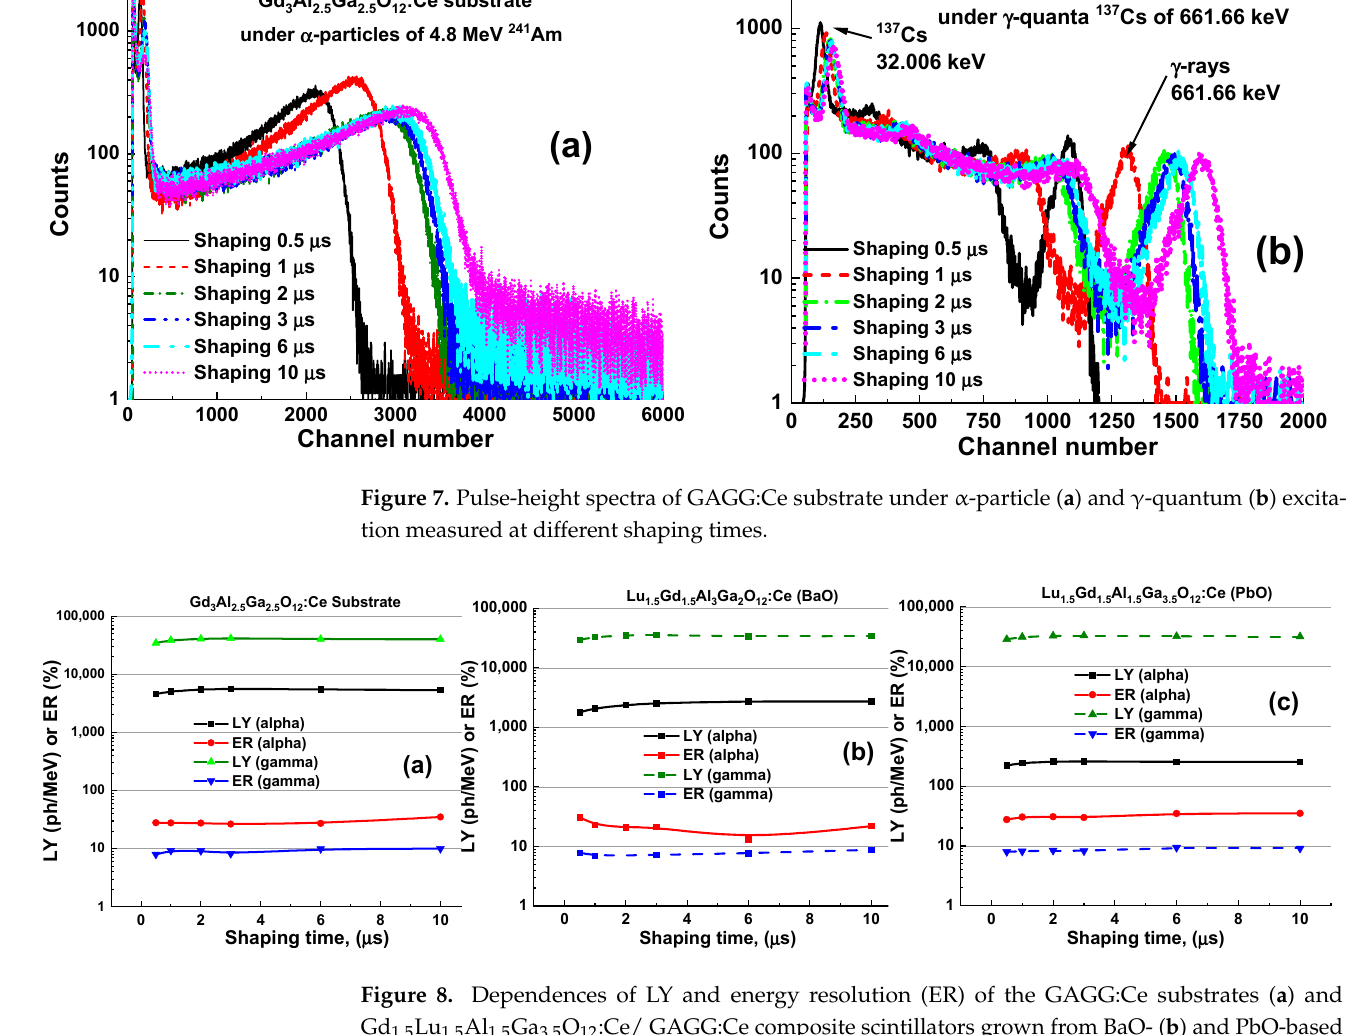
Table 3. Scintillation yield parameters of the selected composite scintillators.